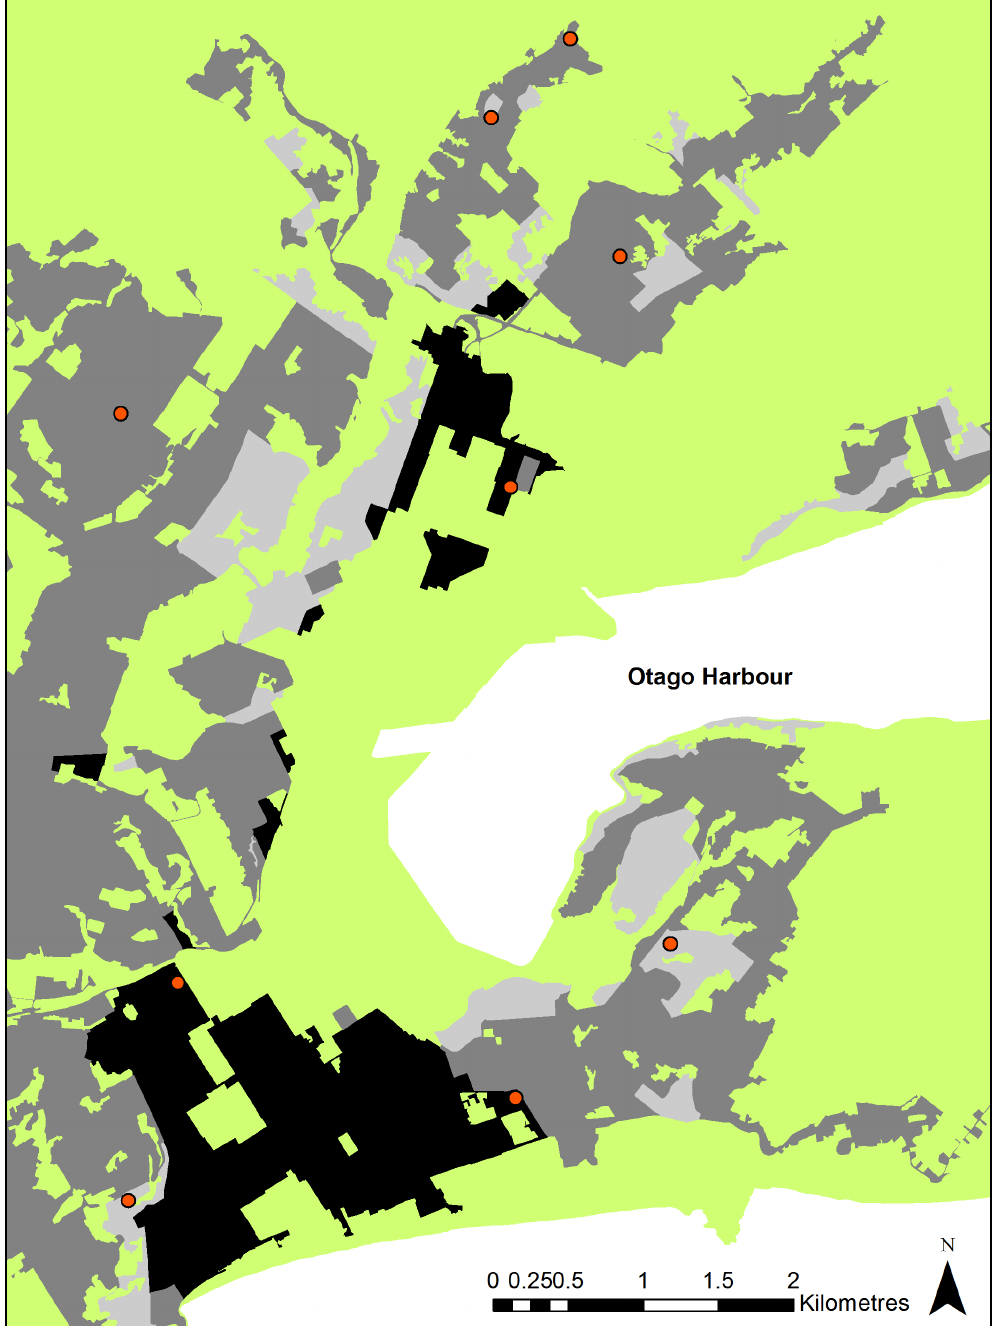
Figure 1. Sampling locations within the suburban environment. Map of the main urban area of Dunedin depicting the sampling locations (orange circles) of stationary GPS collar tests in relation to suburban habitats: Res 1 (light grey); Res 2 (mid-grey); Res 3 (black); and other (light